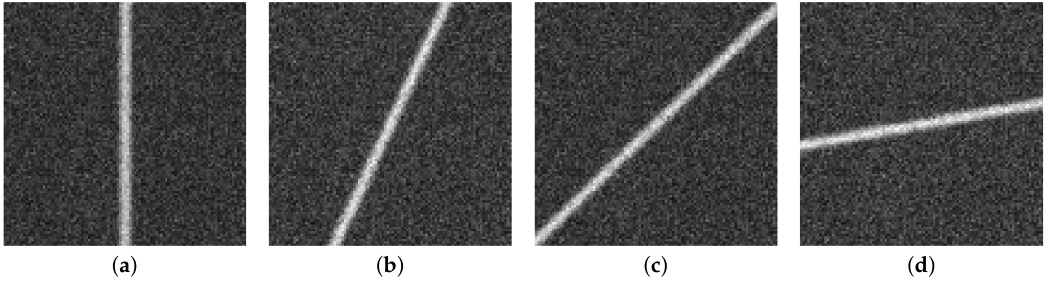
Figure 4. Simulated 101 × 101 pixel images generated with constant contrast ( k = 1), line width ( w = 4), and noise strength ( σ n = 30/255) for ( a ) θ = 0 ◦ ; ( b ) θ = 25 ◦ ; ( c ) θ = 46 ◦ ; and ( d ) θ = 80 ◦